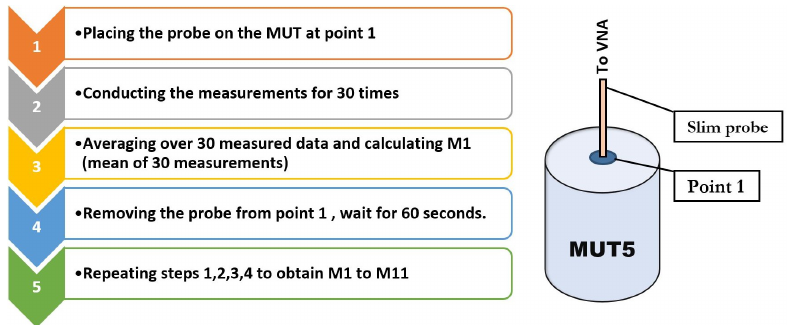
Figure 5. Repeatability measurement steps for MUT5 at one single point.